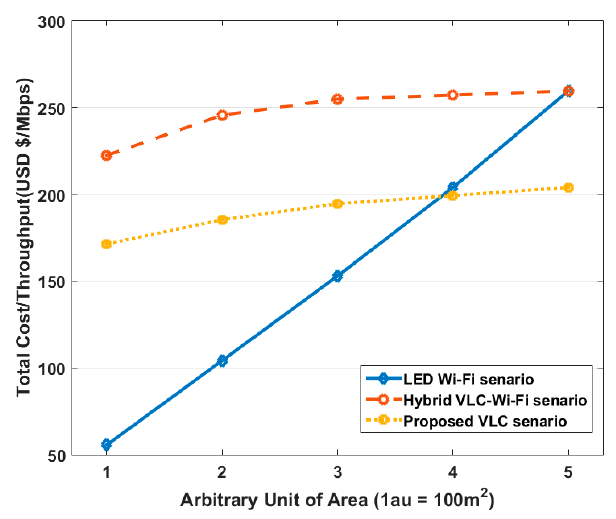
Figure 9. Total cost comparison of architecture 1 for all three systems.